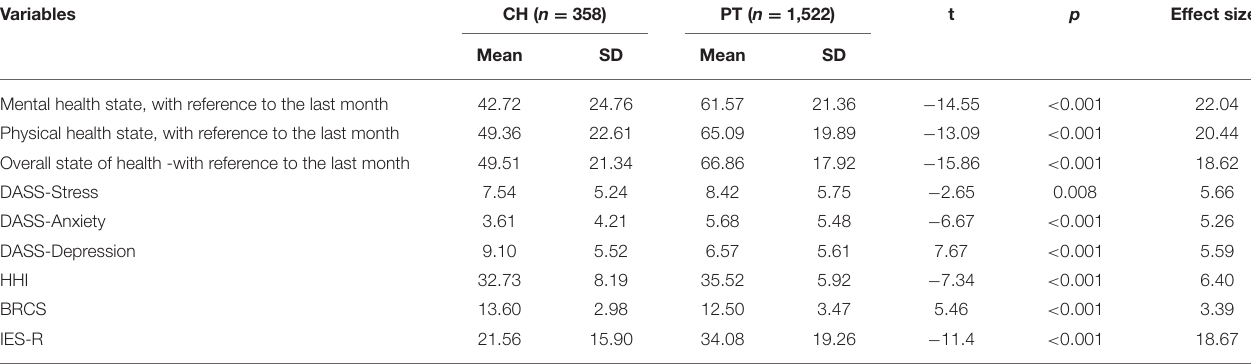
TABLE 2 | Comparison of perceived health status, psychological impact, hope and coping between the two countries (Portugal vs. Switzerland; n = 1,880). Variables p